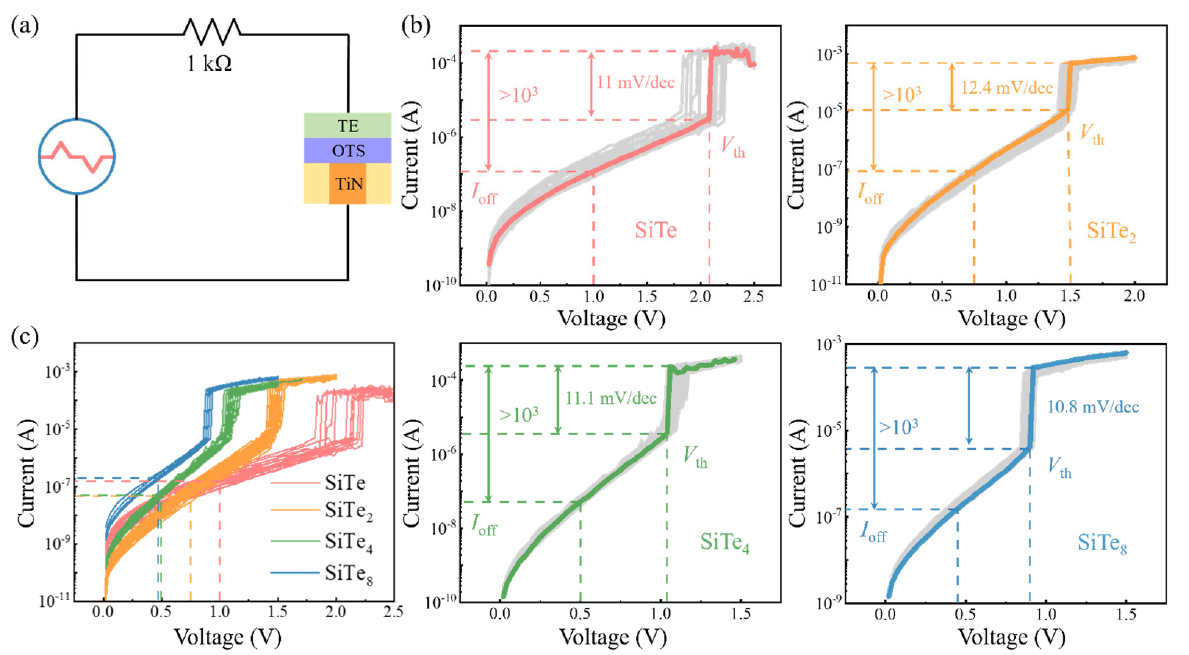
Figure 2. DC curves of devices with di ff erent Si contents. ( a ) A 1 k Ω resistor is in series with the device in the DC testing circuit. ( b ) DC I − V curves of Si − Te devices. ( c ) The synthesized DC curves of four compositions.